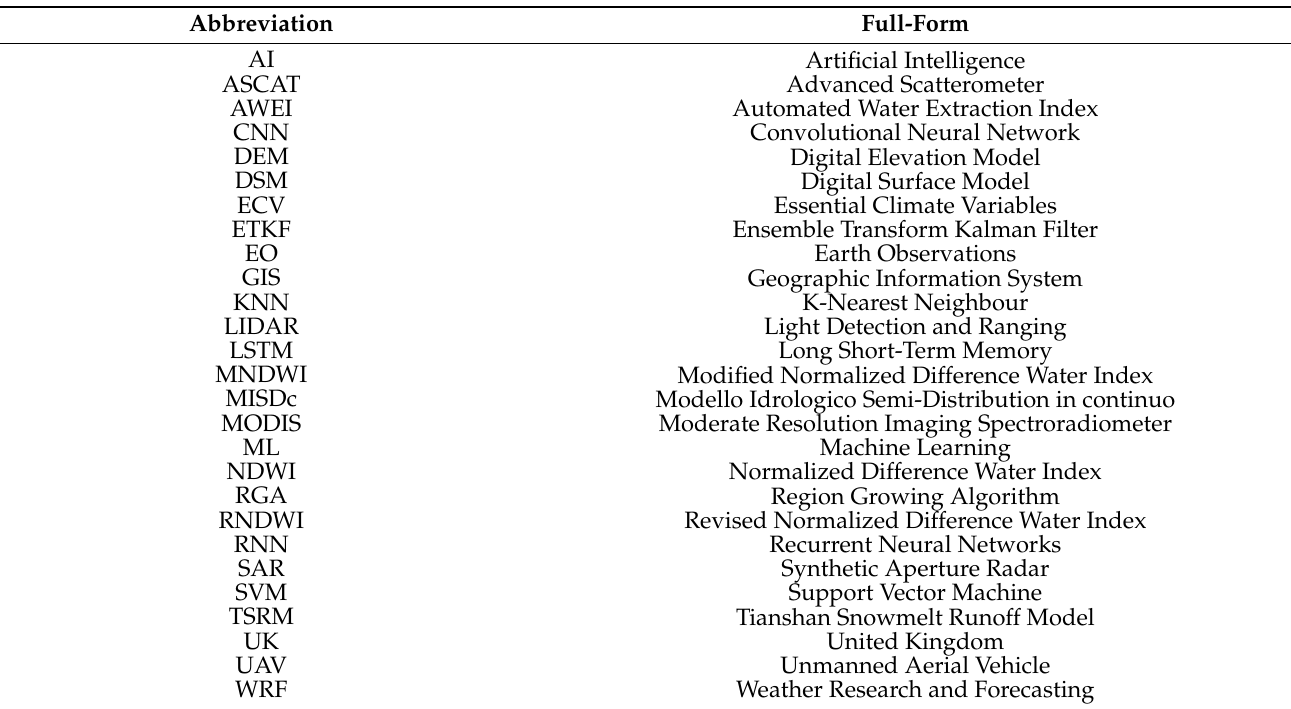
Table 1. List of acronyms used in the